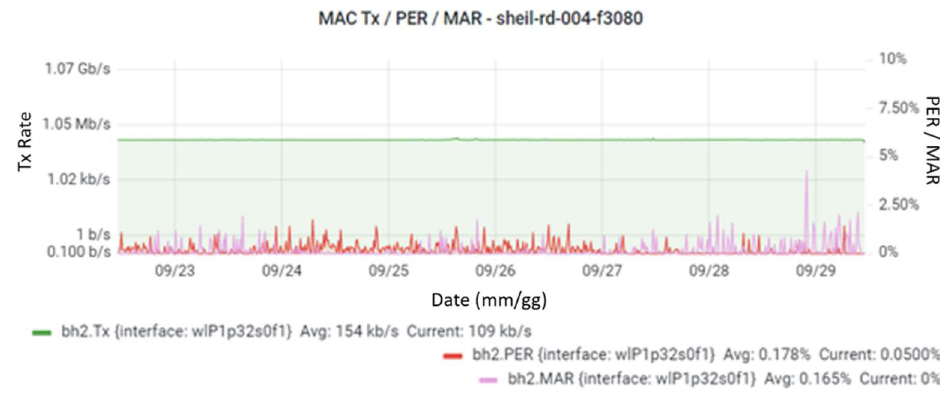
Figure 8. Performance in terms of PER of Link 2.